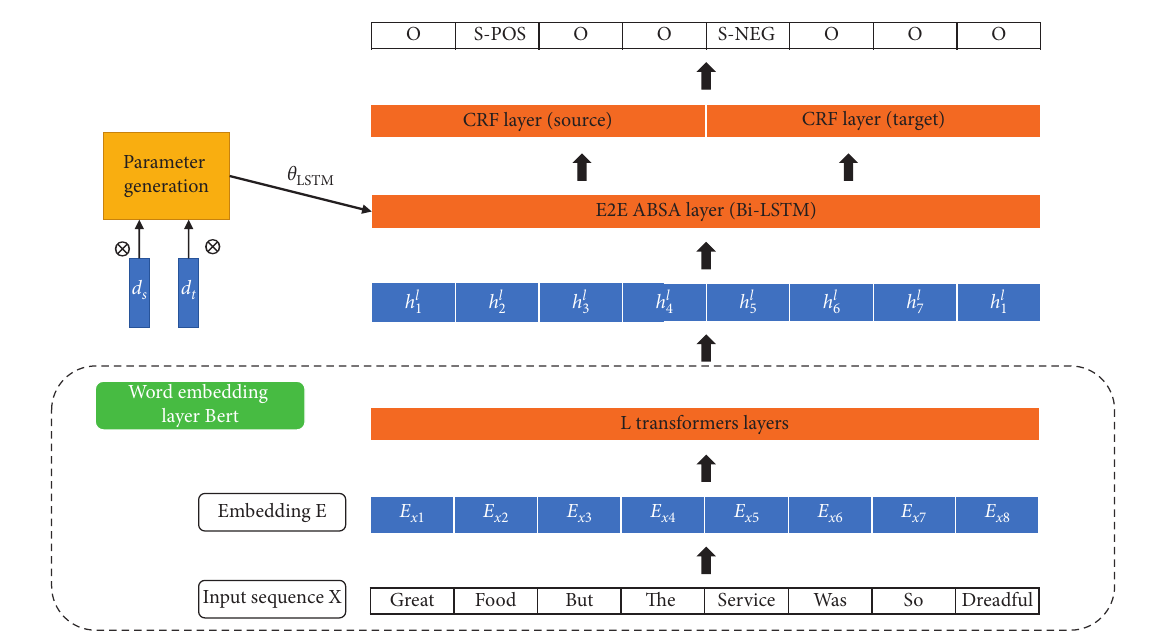
Figure 3: The structure of